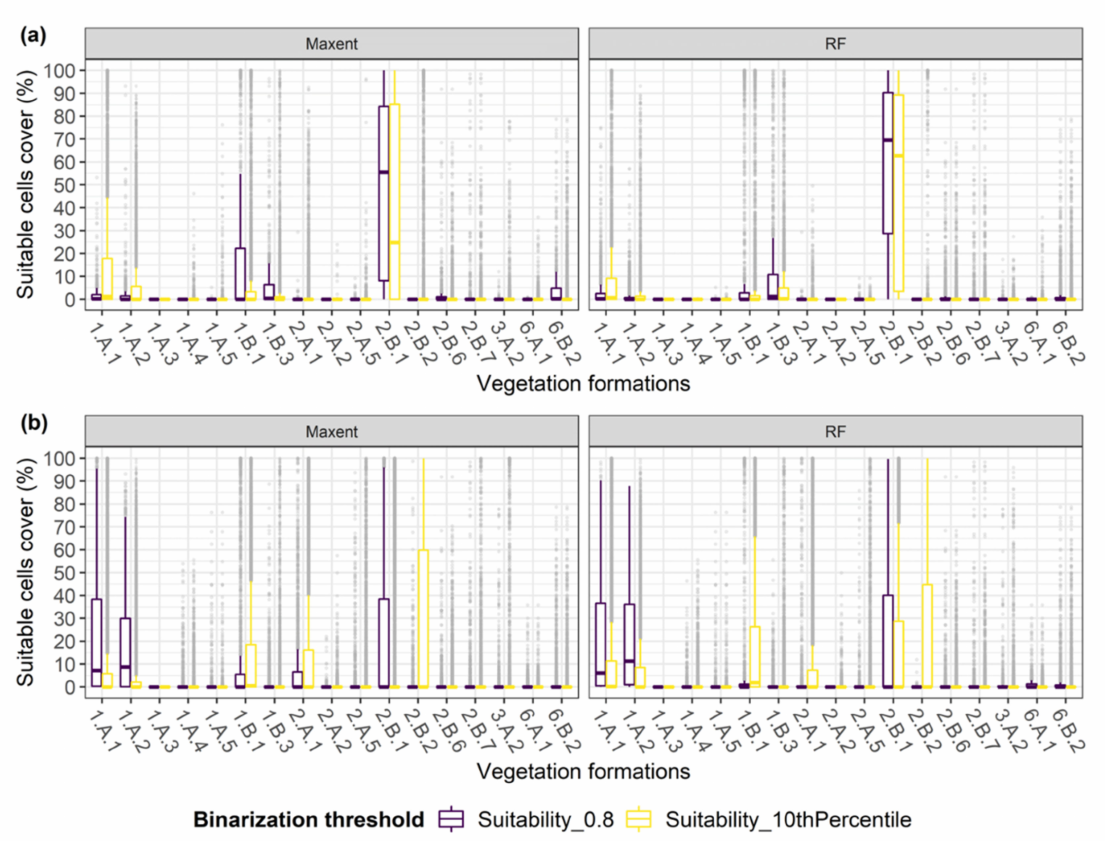
Figure 9. Percentage coverage by each of the 17 vegetation formations (see Table 1) of the pix- els predicted as climatically suitable after binarizing the Maxent-derived (left) and RF-derived (right) weighted average predictions through either the 10th percentile training threshold or the HS ≥ 0.8 threshold, for: ( a ) Chaetocnema darwini ; ( b ) C. natalensis